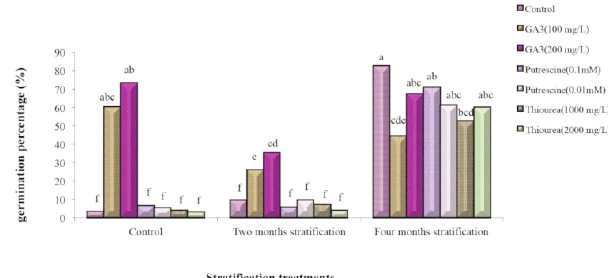
fig. 5 - effect of stratification and chemical treatments on seed germination percentage of hazelnut